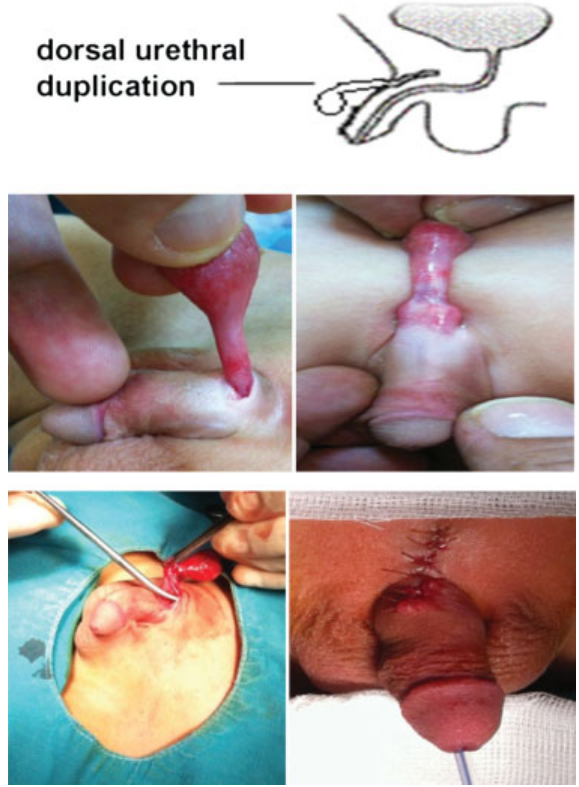
Fig. 1 Prepubic sinus with tissue mimicking corpus spongiosum.